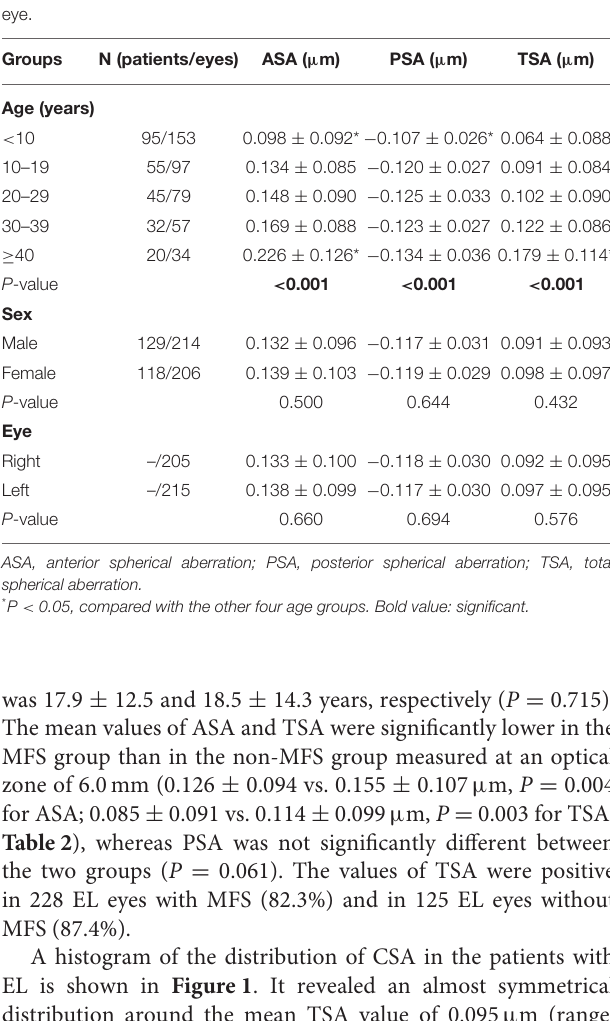
for the poor quality of Pentacam measures or a history of ocular surgery.